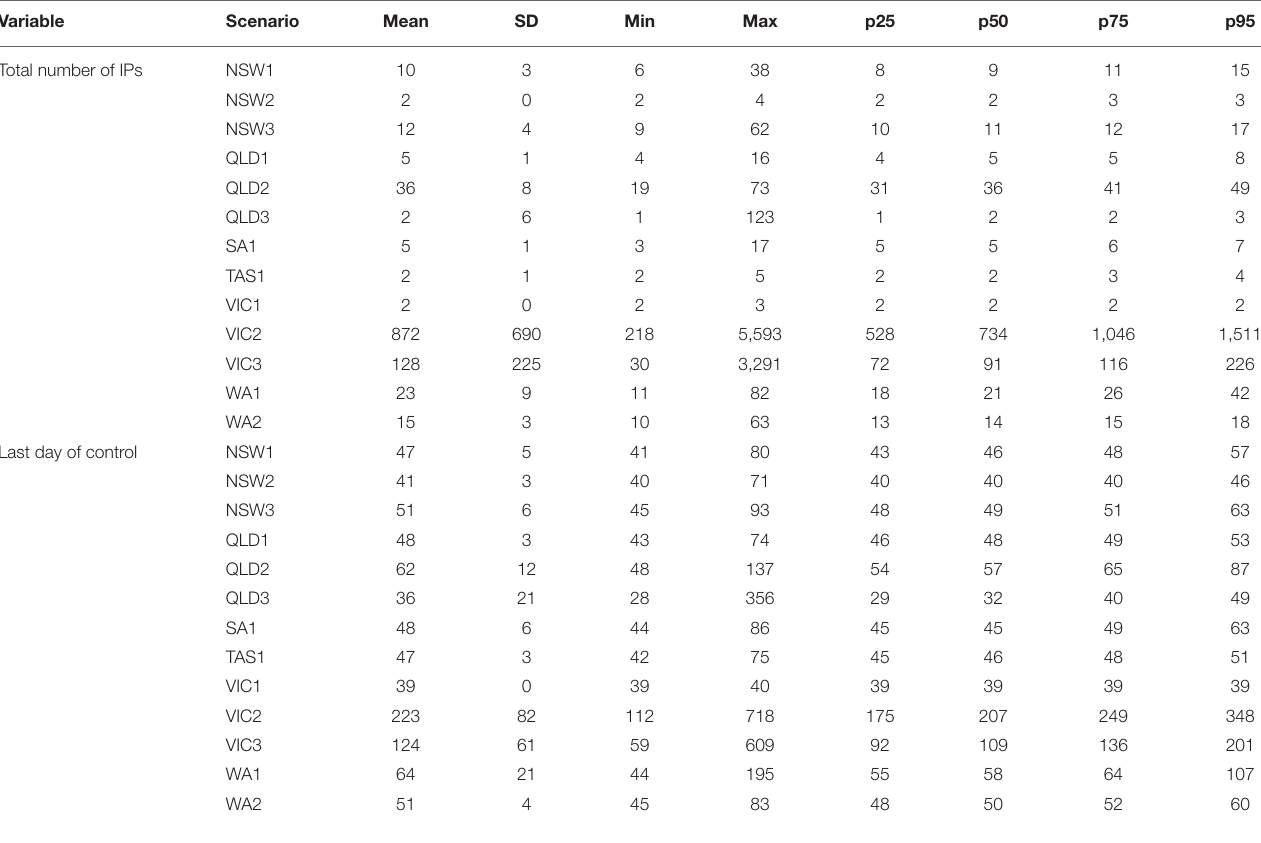
TABLE 4 | Descriptive statistics for the Control Strategy 1 benchmark control strategy for all incursion scenarios.